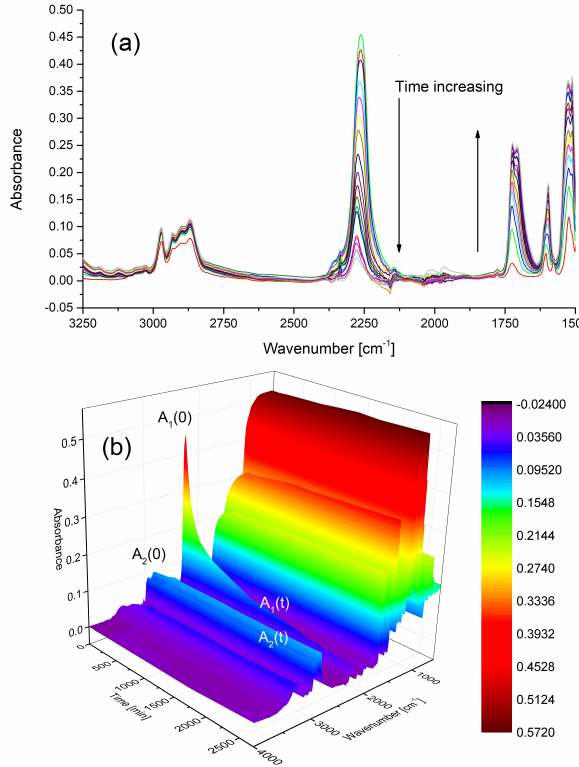
Figure 7: FTIR spectrum measured for the pure PU sample with PR=0.33 at different reaction times (a) and transformed into a 3- dimensional spectrum